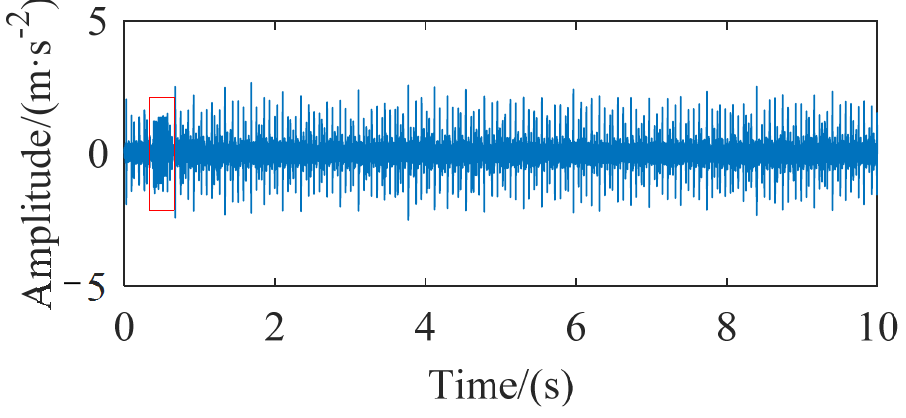
Figure 13. Abnormal data detection results of drive end signal with proposed method.